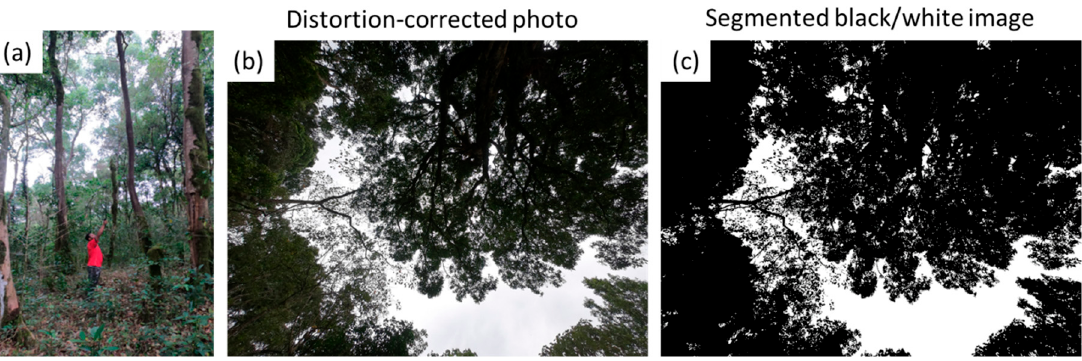
Figure 2. ( a ) Photo of action of taking canopy photos in the forest. ( b ) Examples of distortion-corrected photos and ( c ) the corresponding segmented photo to derive the canopy cover fraction.